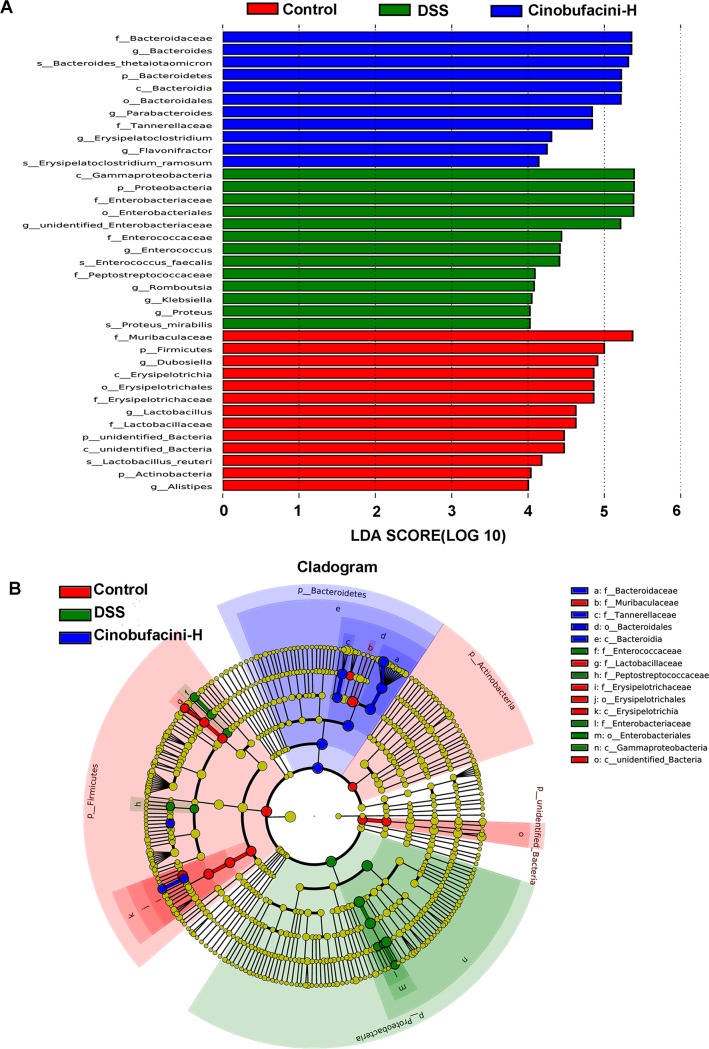
The significantly enriched bacterial taxa in different groups as determined by LEfSe analysis.(A) LEfSe analysis shows differentially abundant bacterial taxa in gut microbiota of different groups (LDA sore >4). (B) LEfSe taxonomic cladogram. The size of each node represents the relative abundance of the species. (p, phylum; c, class; o, order; f, family; g, genus; s, species). The dose of cinobufacini was 30.0 mg/kg body weight. All values are mean ± SD (n = 6 mice/group).